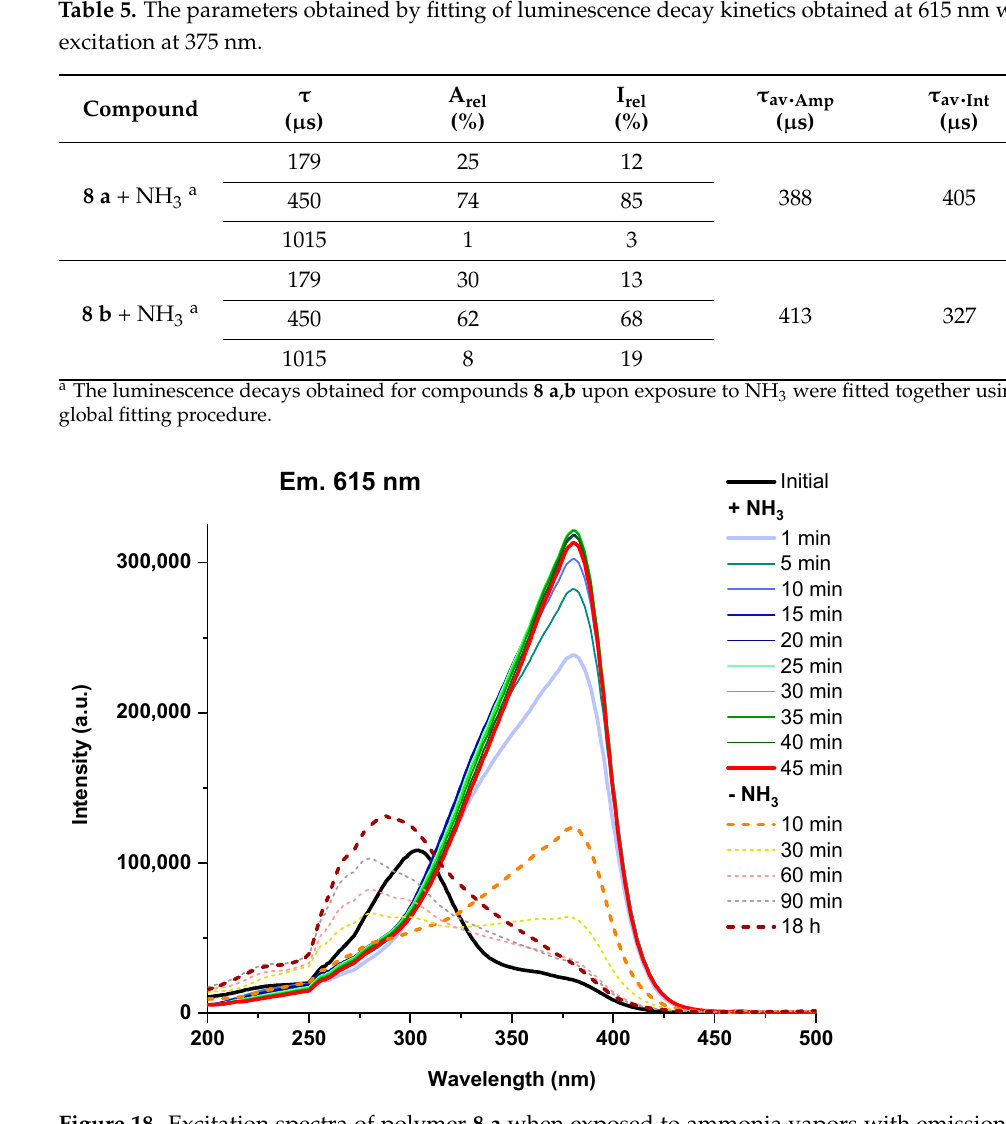
Figure 18. Excitation spectra of polymer 8 a when exposed to ammonia vapors with emissions at 615 nm.